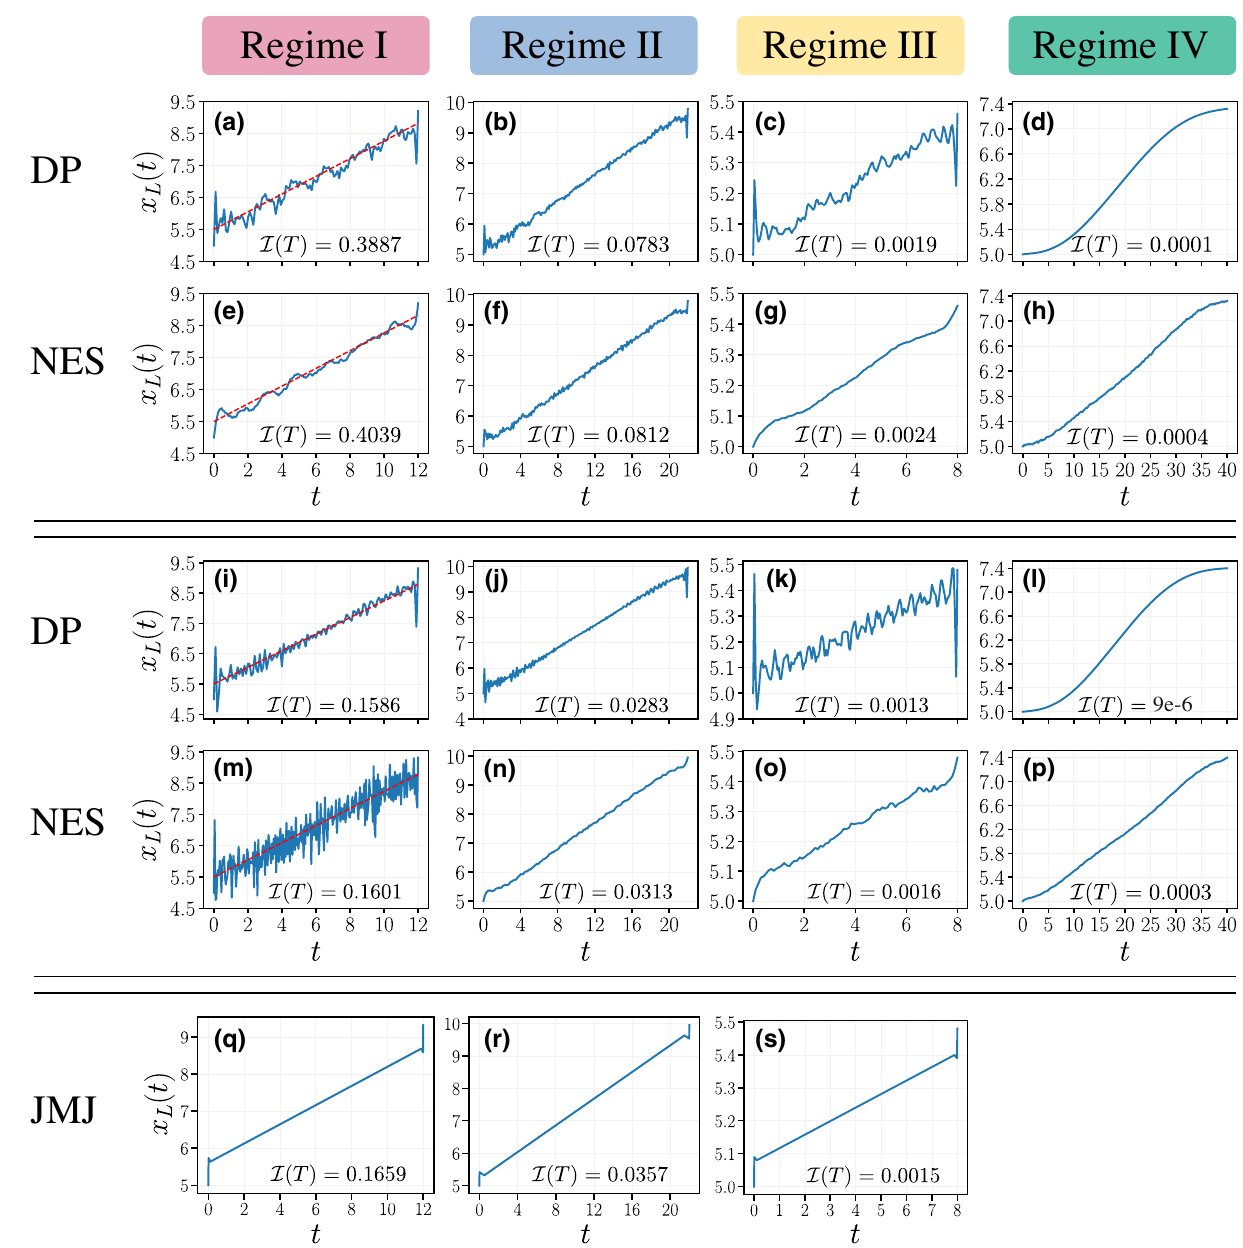
FIG. 13. Overview of the optimal controls in the four different Majorana motion regimes (I–IV) obtained after optimization with DP, NES, and the parameterized JMJ protocols for the proximity-coupled NW model as given by Eq. (F2). In all panels we plot the domain-wall position x L ( t ) as a function of time starting from x L ( 0 ) = x A = 5.0. The red dotted line in regime (I) has a slope equal to the critical velocity v crit ≈ 0.27 for(a) and (e) and v crit ≈ 0.28 for (i) and (m). The obtained strategies are similar to the strategies obtained for the Kitaev chain in the main text with pulselike motion at the beginning and end in regimes (I)-(II)-(III) being smoother motion in the middle and in regime (IV) a smooth adiabatic protocol. In the simulations for (a)–(h) we set N = 100, μ = 0.0, w = 1, = 30.1, and σ = 1 and for (i)–(s) we set N = 100, μ = − 0.55, w = 1, (cid:3) = 0.5, B = 1, α = 1.0, (cid:3) = 0.8, B = 2, α = 0.8, V height V height = 30.1, and σ = 1. The constraint parameters ( l , T ) are given by { ( 4.32, 12 ) , ( 4.95, 22 ) , ( 0.48, 8 ) , ( 2.4, 40 ) } for regimes (I), (II), (III), and (IV),